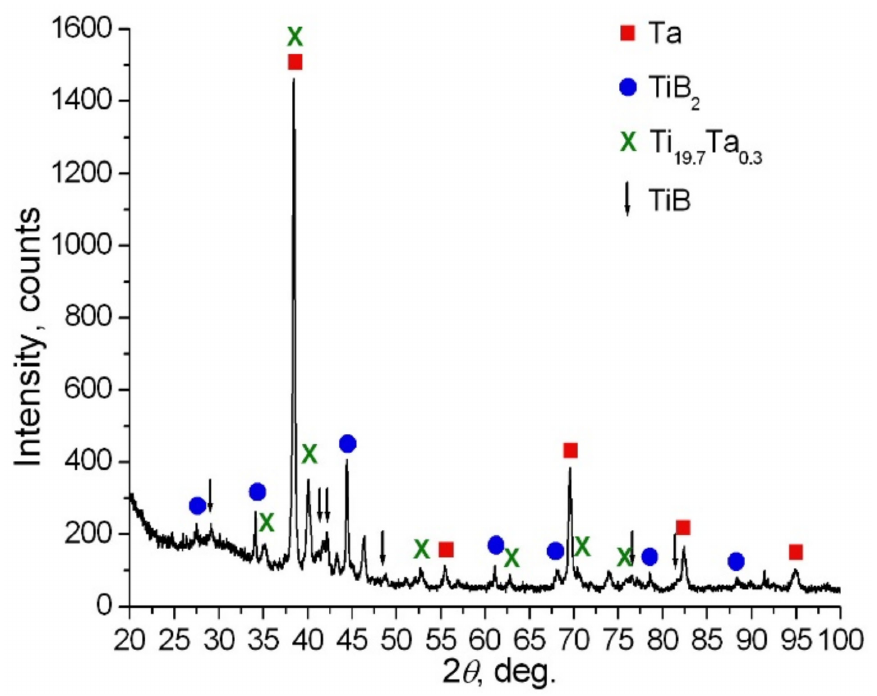
Figure 3. Diffraction pattern for cross section of burned Set 1